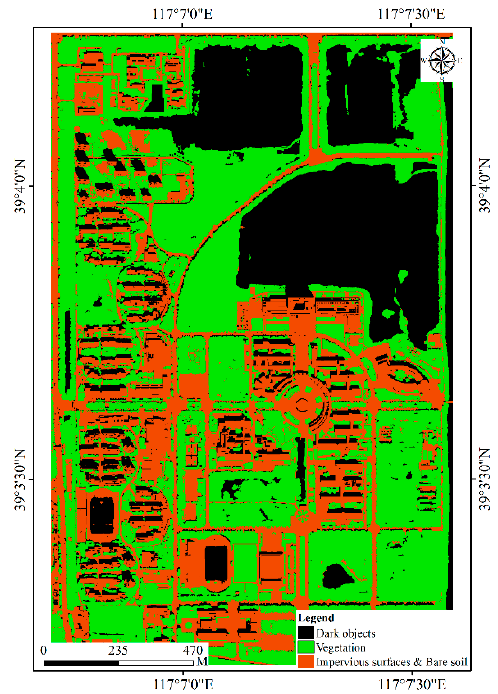
Figure 8. Selected spectral indices.